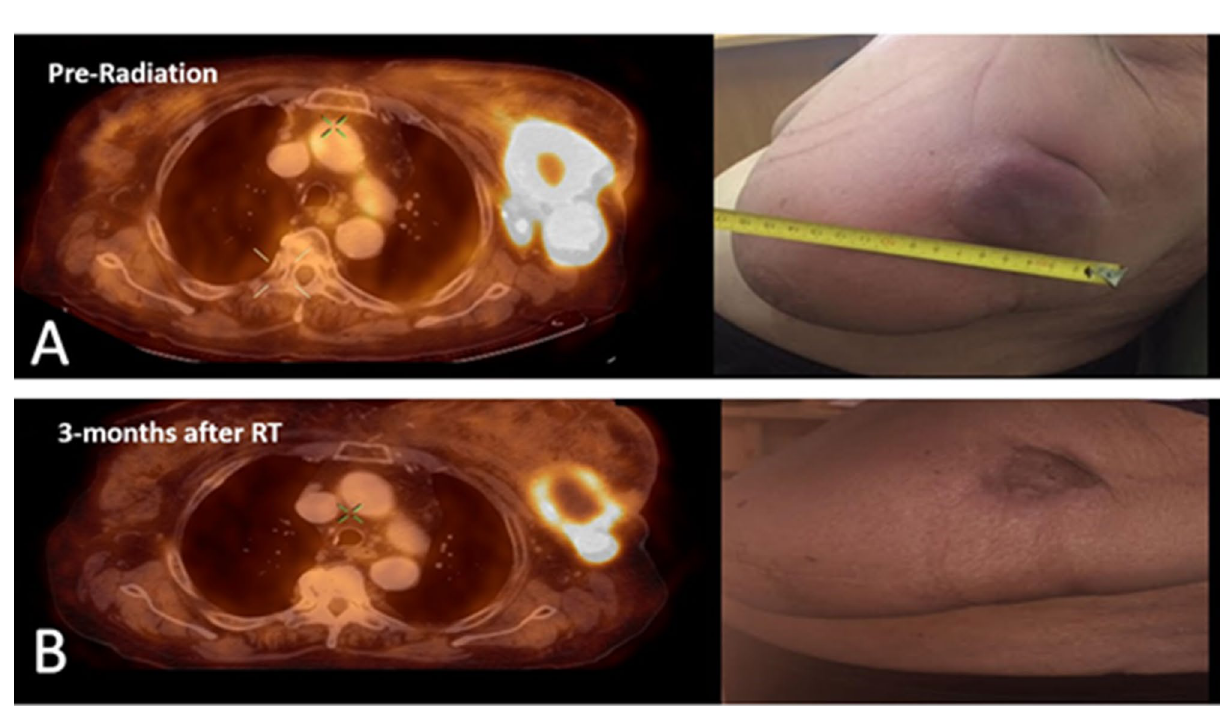
Figure 1. A PET-CT scan and clinical evaluation of a patient with locally advanced breast cancer who was treated with fractionated radiation for palliation. ( A ) Pre-radiation therapy, ( B ) 3 months after radiation